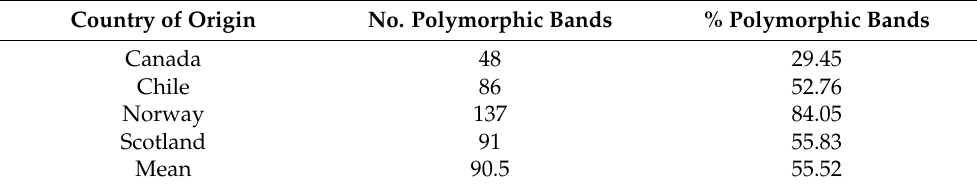
Table 3. The number and percentage of polymorphic bands resulting from the AFLP analyses of Saprolegnia spp. in the